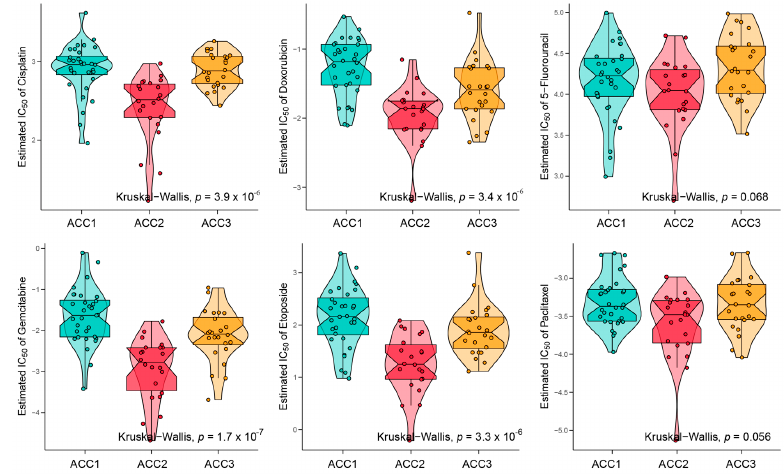
Figure 6. Differences in chemotherapy susceptibility between the three subtypes.